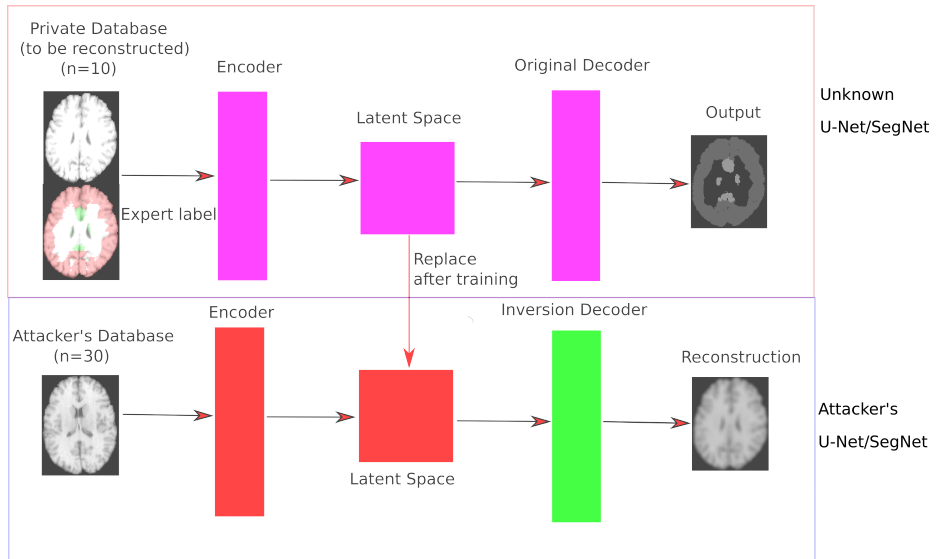
Figure 3. Schematic flowchart of an inversion attack. The original network includes the encoder, which leads to the latent space, and the corresponding decoder path that produces the task-specific output. Using the latent space information and an independent database of training images, a separate (inversion) decoder is trained to reconstruct the original images. This decoder is trained to minimize the difference between the original image and the reconstructed